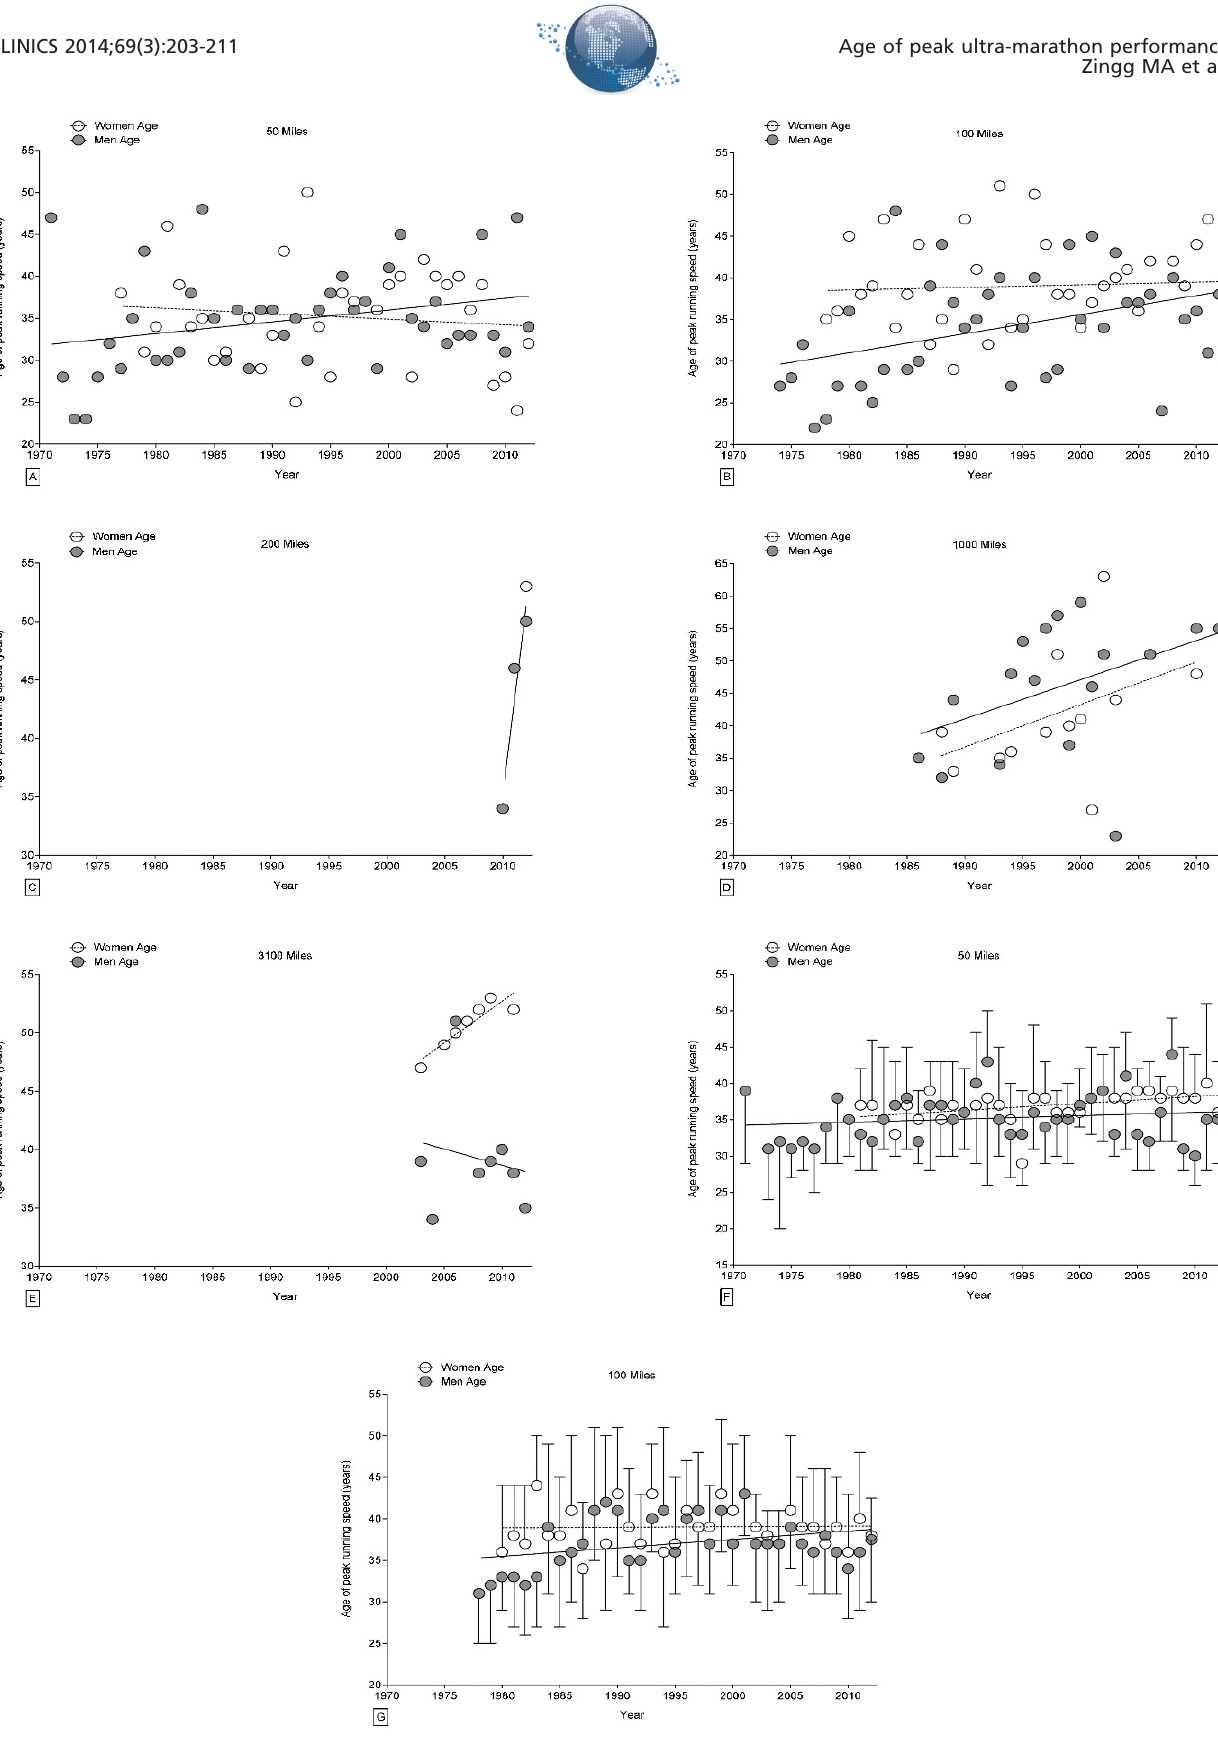
Figure 3 - Age over time of the annual fastest runners for 50 miles (Panel A), 100 miles (Panel B), 200 miles (Panel C), 1,000 miles (Panel D), and 3,100 miles (Panel E) and for the annual ten fastest runners for 50 miles (Panel F) and 100 miles (Panel